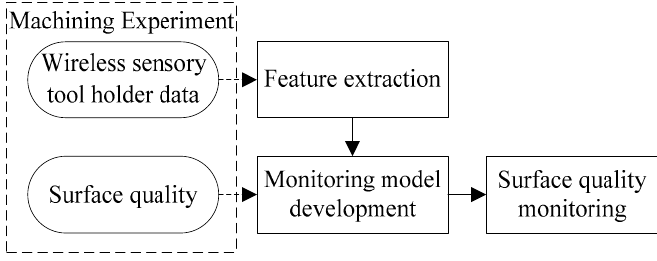
Figure 1. Flowchart of the proposed scheme.